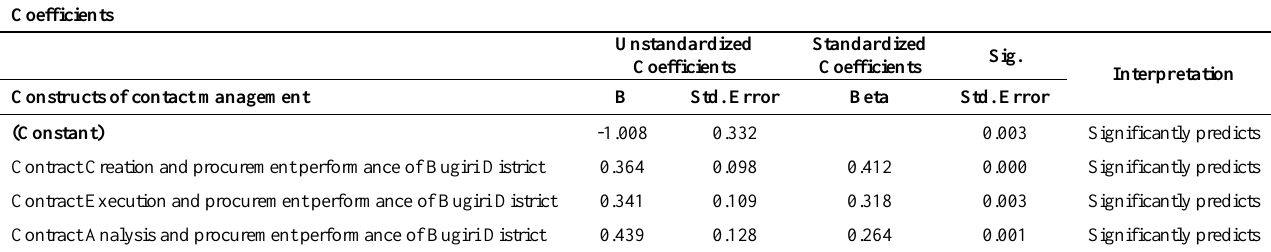
Table 4. The coefficients of the study and how they predict procurement performance in Bugiri